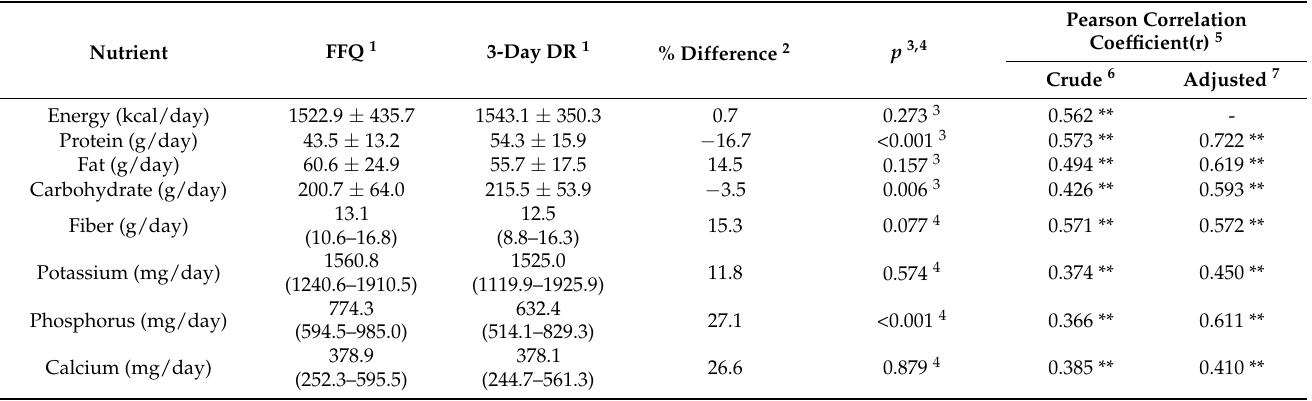
Table 2. Correlations between data obtained by the food frequency questionnaire (FFQ) and 3-day dietary recall (3-day DR) (n = 107).